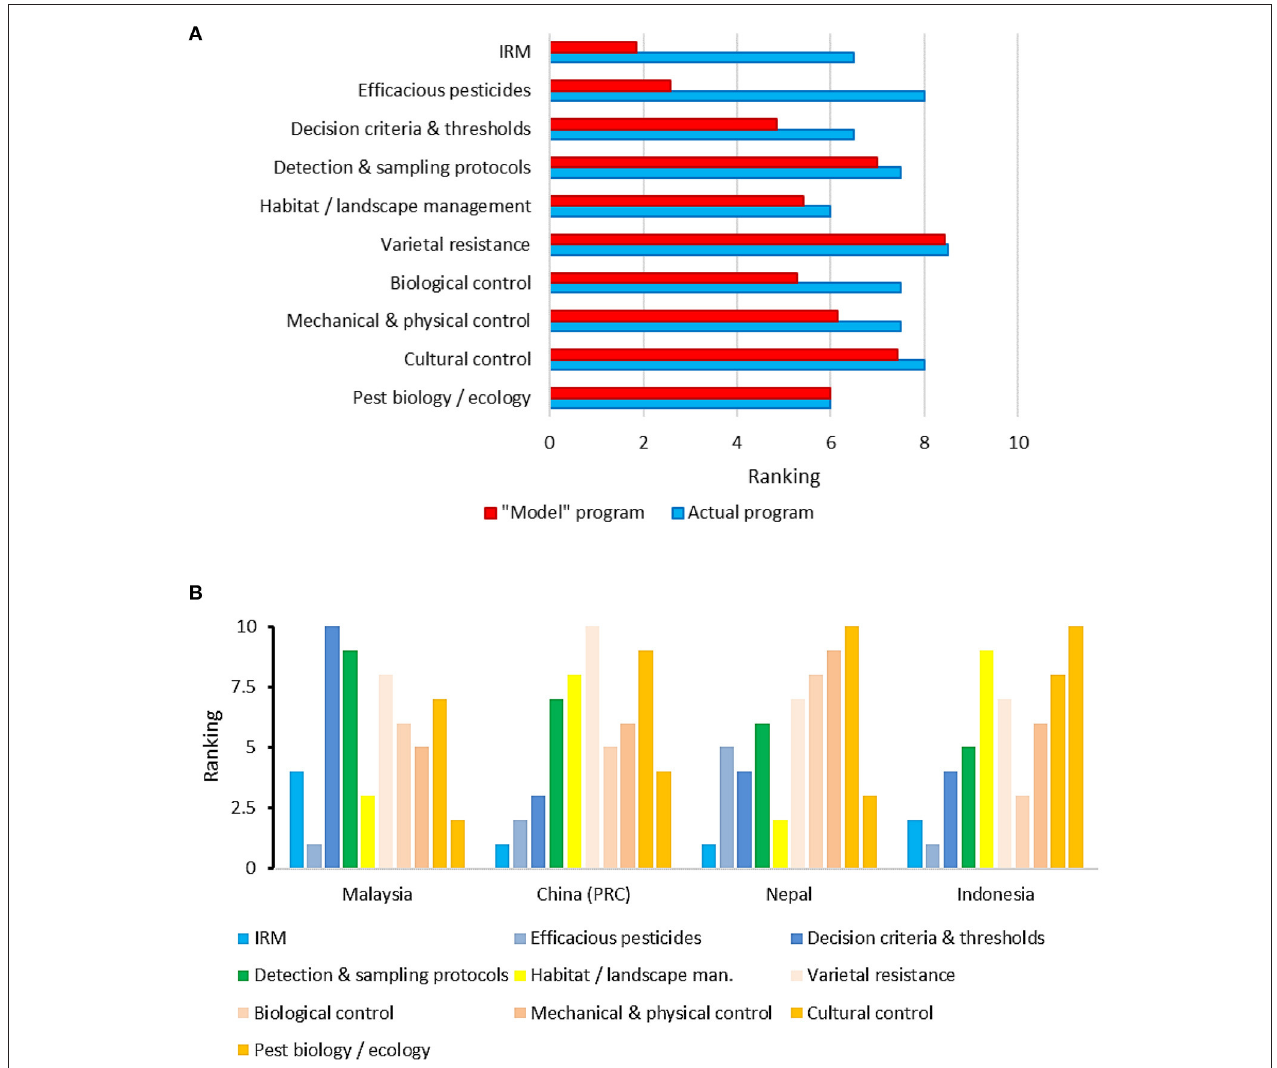
FIGURE 1 | Lay-out of the current and “model” IPM program, as envisioned by respondents from seven Asia-Pacific countries. Panel A shows consolidated patterns for the current and “model” IPM program of all countries, while Panel B depicts “model” IPM programs for four specific countries. Individual components are ranked in accordance with the IPM conceptual model or “pyramid” (Naranjo, 2011). In (A) , different ranking scales were used to assess the relative composition of current and “model” programs. In (B) , the length of each bar mirrors the relative degree of attention a given component merits within a comprehensive IPM program. Color-schemes reflect whether components constitute avoidance tactics (yellow; base of the IPM pyramid), sampling (green) or effective chemical use (blue). IRM refers to insecticide resistance